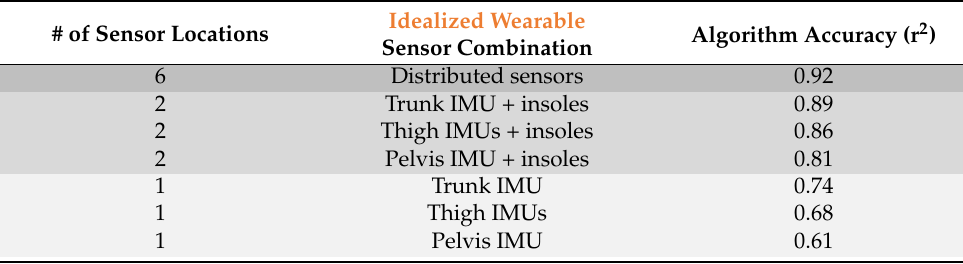
Figure 2. Maximum algorithm accuracy increased with number of sensor locations. Average accuracy using idealized wearable sensors summarized here using the average coefficient of determination (r 2 ) across all participants. Orange dots represent the distributed sensor algorithm ( right ) and the highest accuracy algorithms using 1 ( left ) and 2 ( center ) sensor locations. All the algorithms here were developed with idealized wearable sensor signals and the target was lumbar extension moment. The top three algorithms using one and two sensor locations are reported in Table 3. A detailed summary of all the algorithm accuracies and the exact sensor combinations for each algorithm is included in Figure A1. Table 3. Algorithm accuracy for a subset of idealized wearable algorithms. Average accuracy for the distributed sensor algorithm and the top three algorithms requiring one or two sensor locations. Accuracies reported here correspond to data points in Figures 2 and